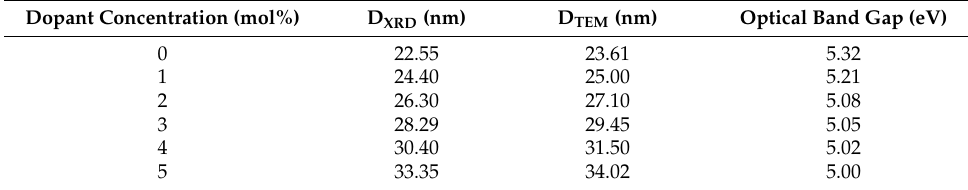
Figure 4. ( a ) XRD spectral patterns of willemite nanoparticles (NPs) at various calcination temperatures between the range 500–1000 °C, ( b ) XRD patterns of willemite with different Ce 3+ doping concentration calcined at 900 °C. Table 1. Summary of the structural and optical properties of willemite doped with Ce 3+ calcined at 900 °C with different doping concentration.